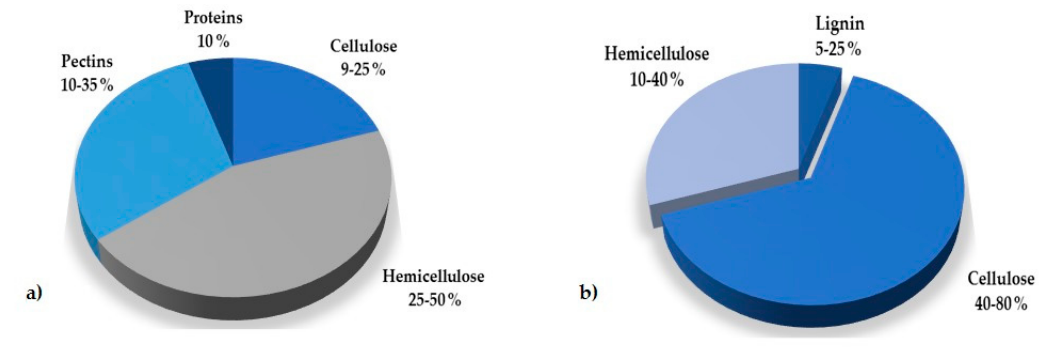
Figure 1. Composition of the cell wall in plants. ( a ) primary wall, ( b ) secondary wall.